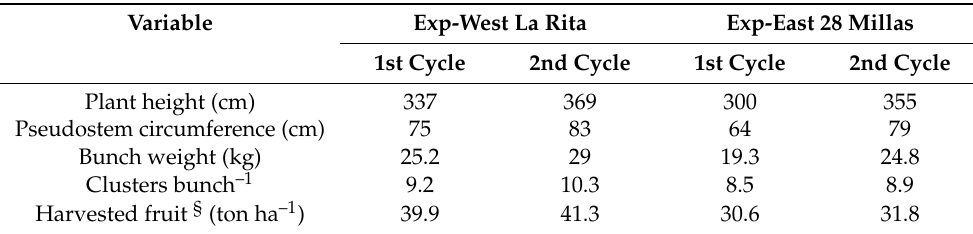
Table 4. Agronomic performance in the 1st and 2nd of Gros Michel banana inoculated with Foc Race 1 in two experiments (Exp-west and Exp-east) from two locations (La Rita and 28 Millas